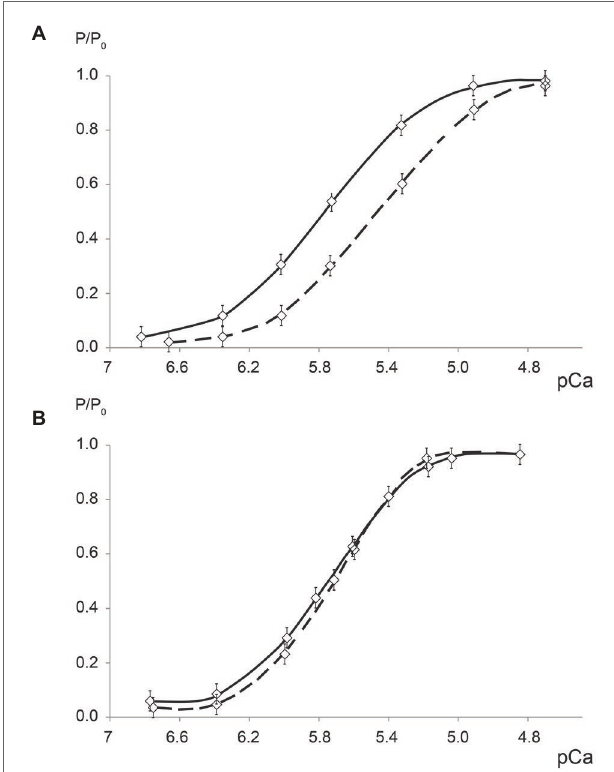
FIGURE 1 | Calcium-tension relationships in permeabilized fibers of human soleus before and after 7-day dry immersion with (A) and without (B) plantar mechanical stimulation (Shenkman et al., 2004). With kind permission from NAUKA Publishing House (Official Publishers of BIOFIZIKA